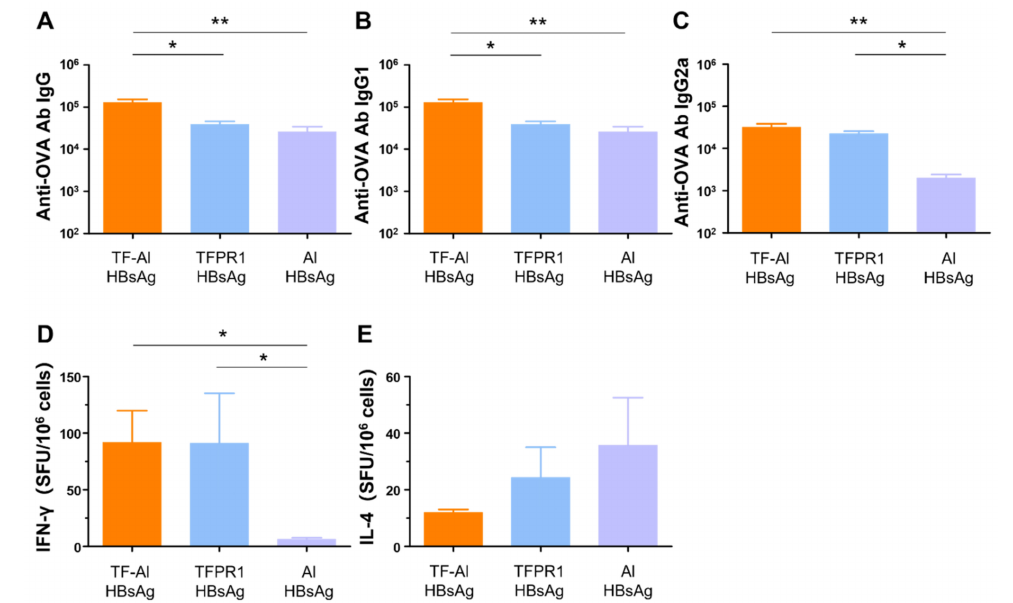
Figure 6. Anti-HBsAg antibodies and cellular immune responses in BALB/c mice immunized with TF–Al plus HBsAg. BALB/c mice were inoculated twice with TF–Al plus HBsAg, TFPR1 plus HBsAg or alum plus HBsAg intramuscularly. On the second week after the final immunization, anti-HBsAg antibodies were detected by ELISA, and cellular immune responses were by ELISPOT. ( A ) Anti-HBsAg antibody IgG. ( B ) Anti-HBsAg antibody IgG1. ( C ) Anti-HBsAg antibody IgG2a. ( D ) Specific IFN- γ . ( E ) Specific IL-4. Note: * stands for p < 0.05, ** p < 0.01, and *** p <